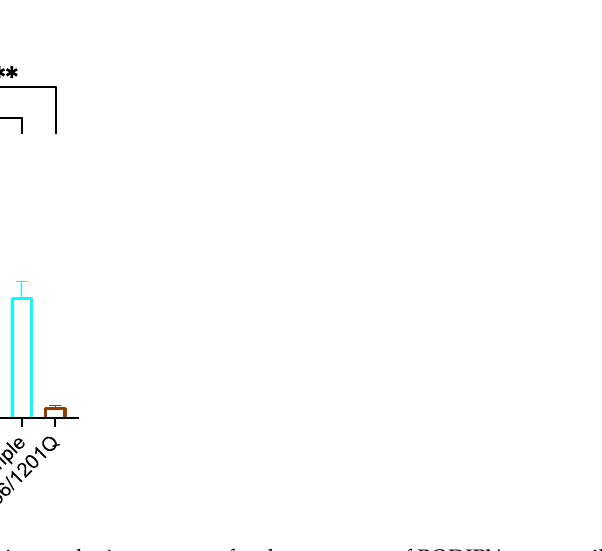
Figure 4. Functionality of glutamine to alanine mutants for the transport of BODIPY-verapamil. Live HEK293T cells transiently expressing equivalent amounts of wild-type (wt) and mutant ABCB1 were challenged with BODIPY-verapamil. Functionality was measured as the ratio of BODIPY-verapamil accumulation between the ABCB1-expressing and untransfected cells within the population. This was normalized to 100% for wild-type ABCB1 for the bar graph shown. The mean ± SEM was plotted using GraphPad Prism version 8; sample number was ≥ 3. Selected statistical analysis (ratio of paired Student’s t-test, two-tailed) performed on the raw data is shown with p values: * < 0.05, ** < 0.01. The full pairwise comparison of the data is given in Appendix A Table A2.